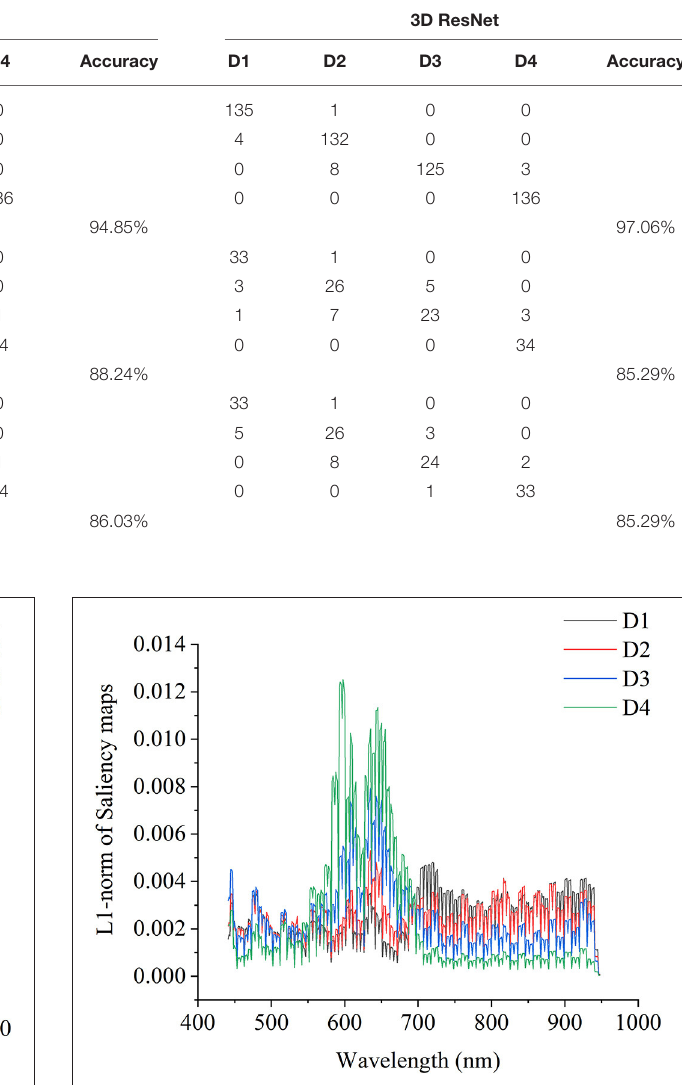
FIGURE 5 | Visualization of the wavelength contribution of the testing set by 1D ResNet.